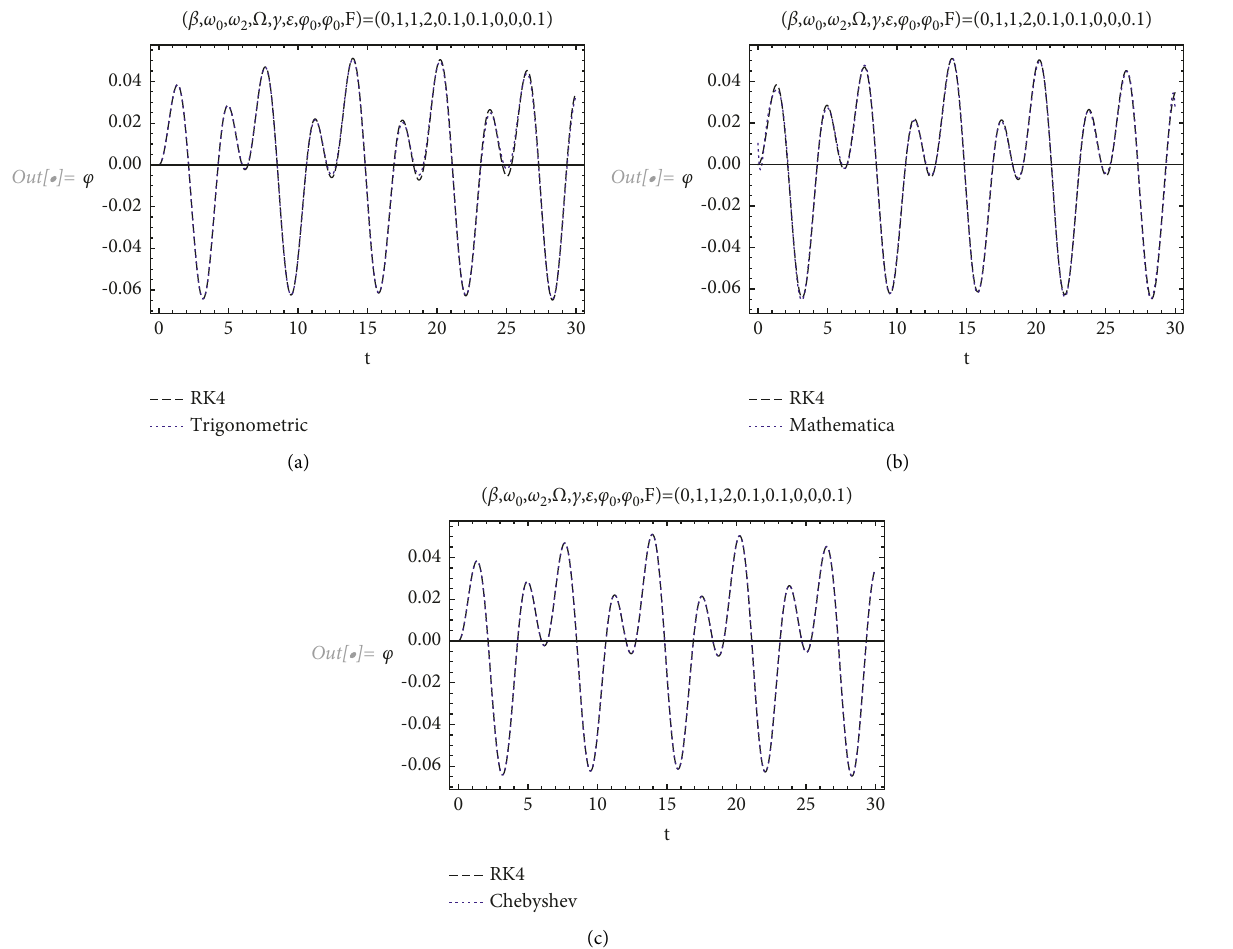
Figure 4: The comparison between the analytical approximation (16) and the numerical approximations using the Chebyshev collocation method and RK numerical method as well as the MATHEMATICA command Fit to i.v.p. (3) for case (2):